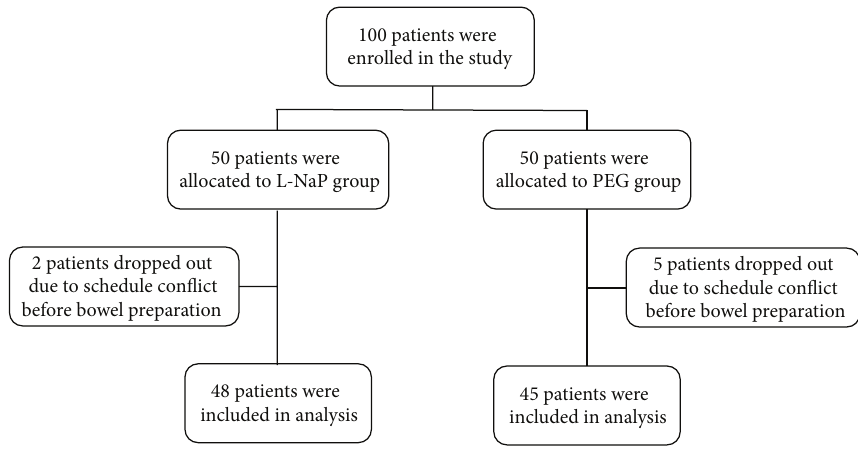
Figure 1: Flow diagram of patient recruitment and summary of treatment outcomes. A total of 100 patients were randomly assigned to two groups. Two patients in the sodium phosphate (NaP) tablet group and 5 patients in the polyethylene glycol solution (PEG) group did not undergo colonoscopy due to schedule conflicts before bowel preparation. They withdrew from the study. Therefore, 93 patients were included in the final analyses (48 in the L-NaP tablet group and 45 in the PEG group).